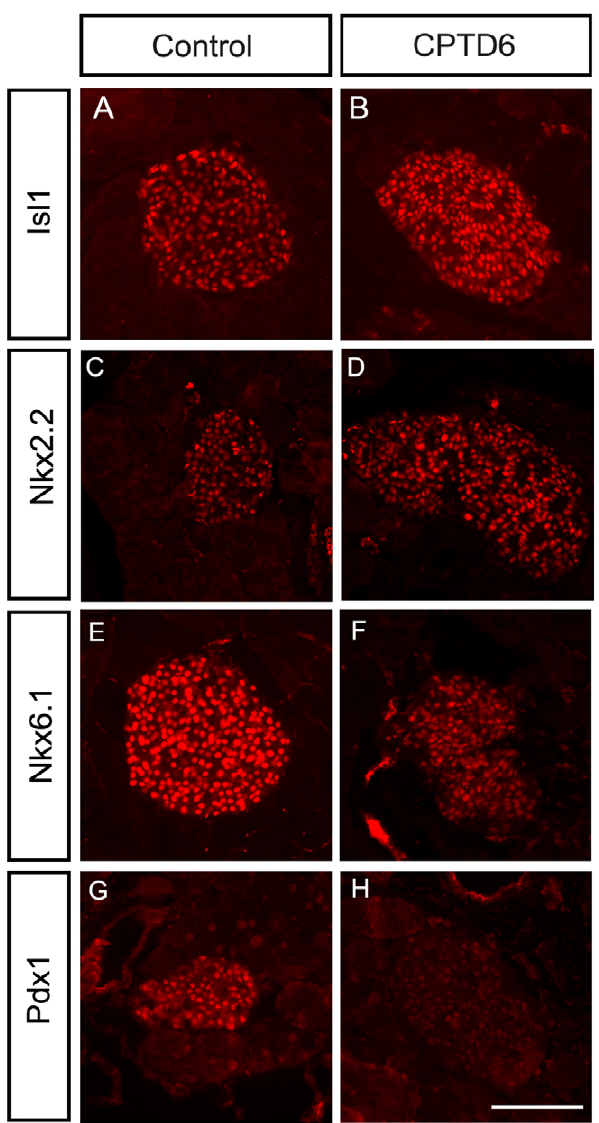
Figure 4. Expression analysis of key transcription factors. Immunohistochemistry was performed in control ( A , C , E , G , I, K ) and CPTD6 ( B , D , F , H , J, L ) mice. ( A , B ) Nuclear expression of the pancreatic islet marker Islet 1 (Isl1) is retained in CPTD6 mice, showing that the islet cells are present. ( C,D ) Expression of Nkx2.2 is also unaffected in CPTD6 mice. ( E, F ) In contrast expression of Nkx6.1 is reduced in Pax6 deficient cells. ( G, H ) The nuclear expression of the transcription factor Pdx1 is lost in CPTD6 mice. Images are representative of at least four animals from each group. Scale bars, 50 m m.